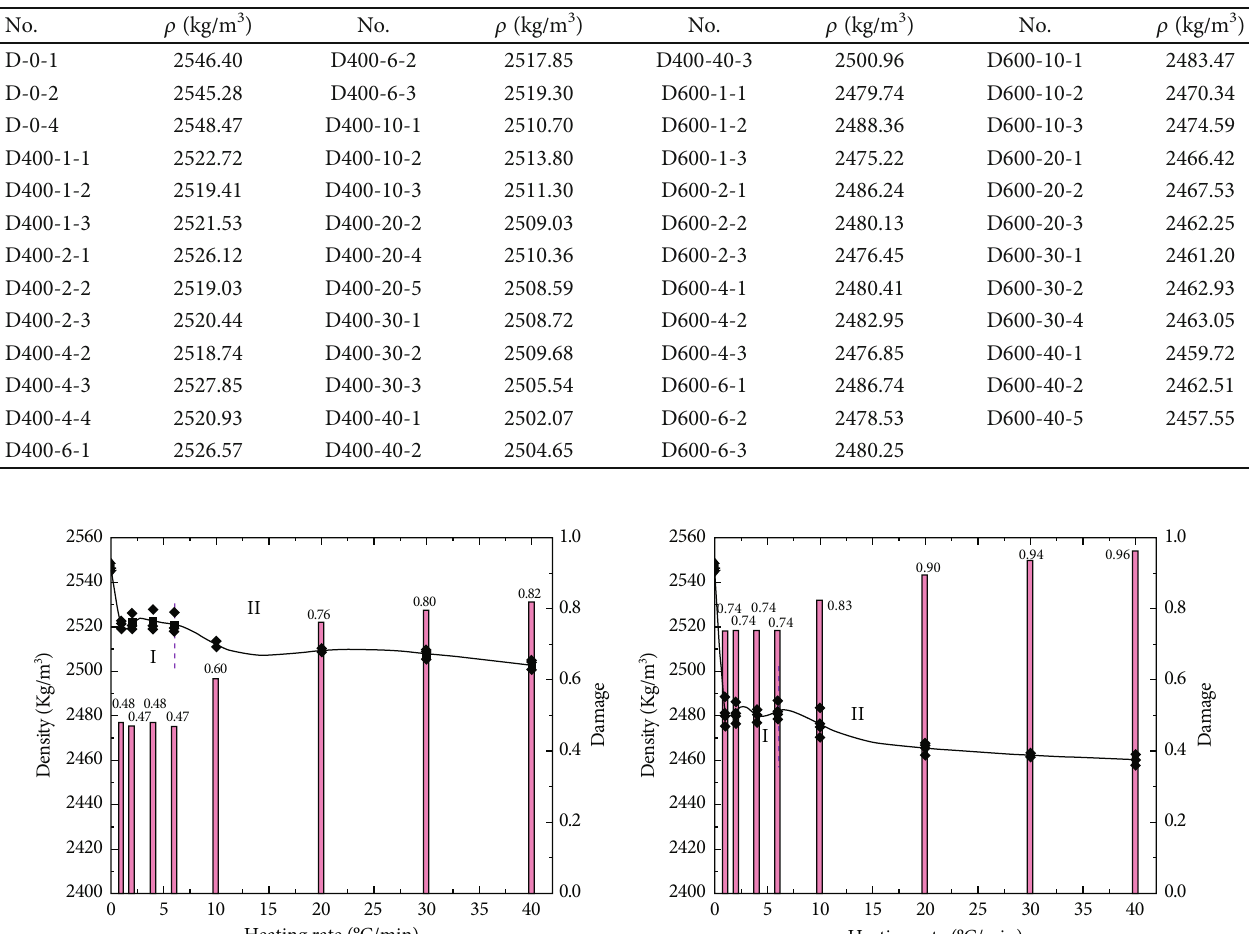
Table 3: Density ( ρ ) of di ff erent thermal treated granite specimens.